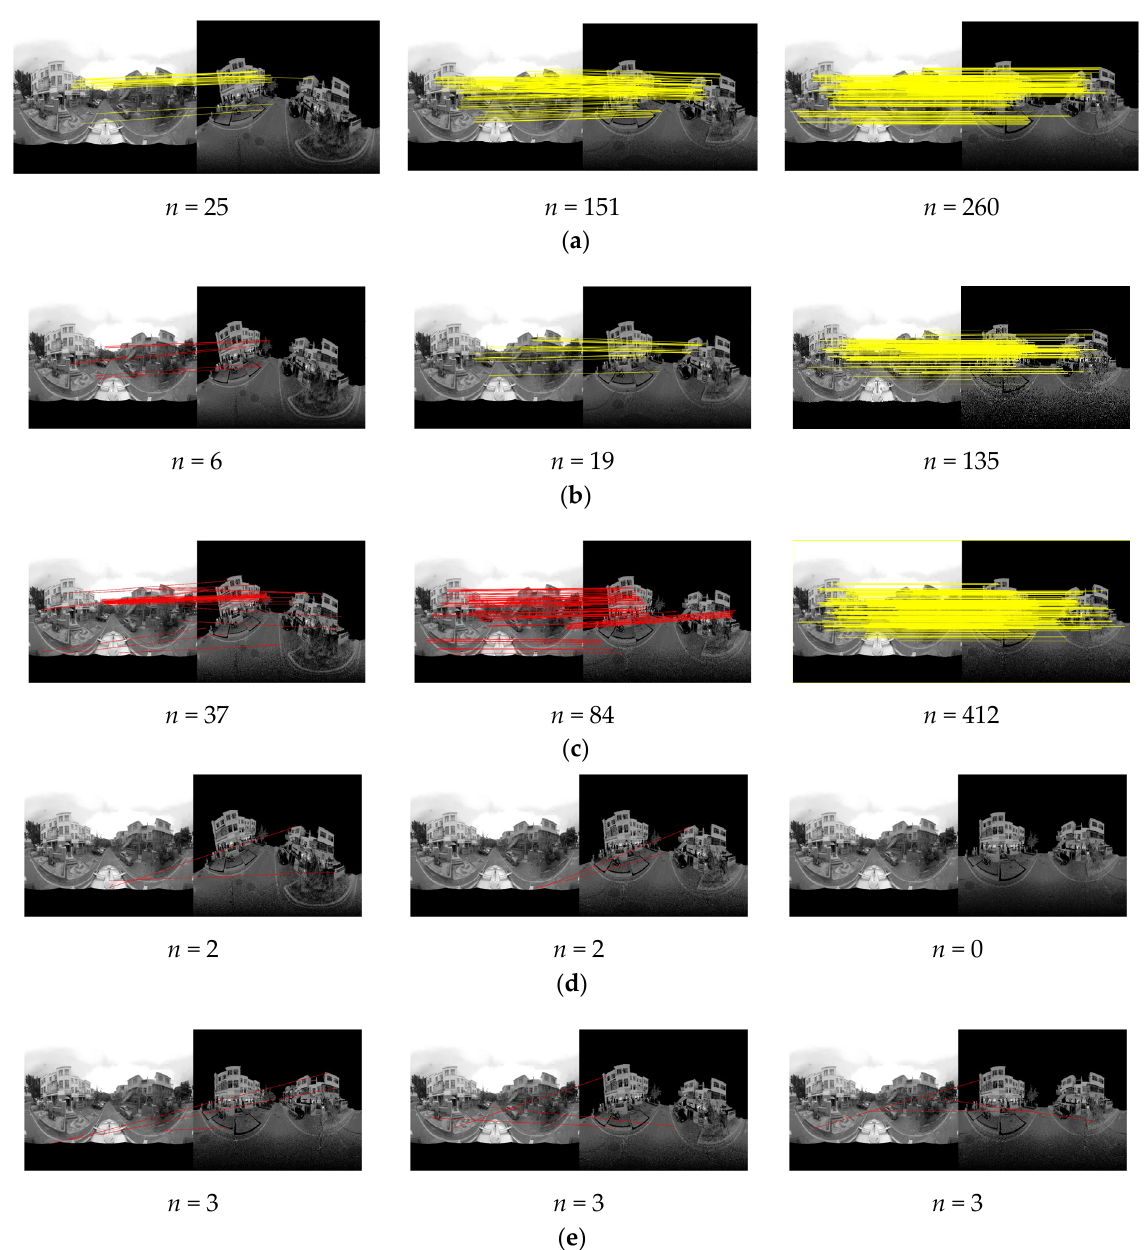
Figure 9. Comparison in the visualization results of our method, RIFT, 3MRS, PSO ‐ SIFT, and SIFT on first test data. ( a ) The results of the proposed method; ( b ) the results of RIFT; ( c ) the results of 3MRS; ( d ) the results of PSO ‐ SIFT; and ( e ) the results of SIFT.